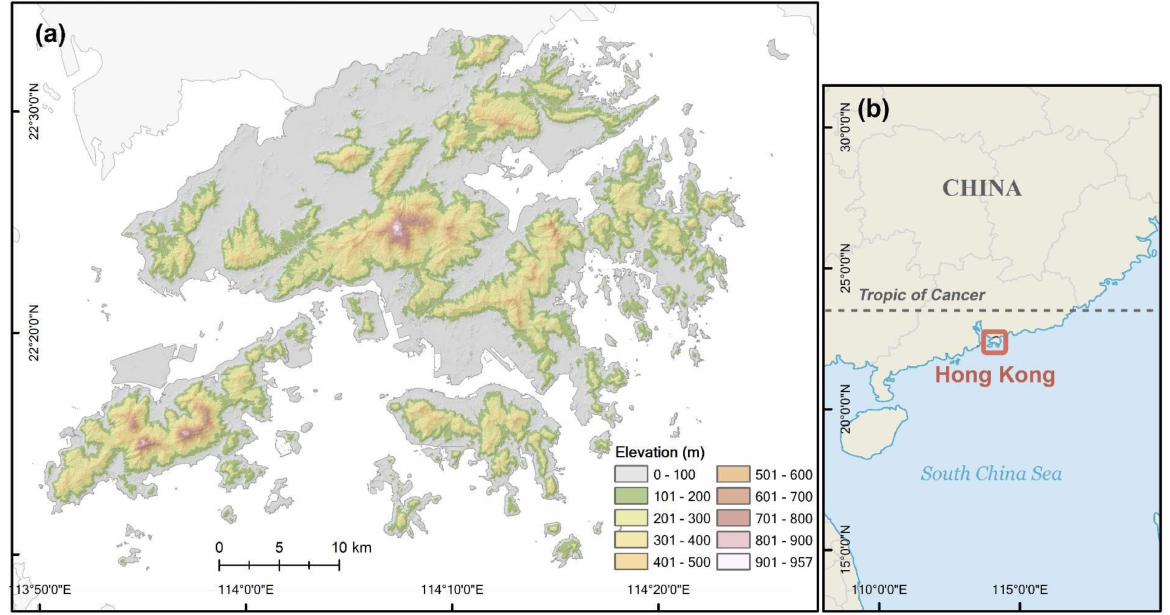
Figure 1. ( a ) The study area of this study; ( b ) location of Hong Kong in East Asia.